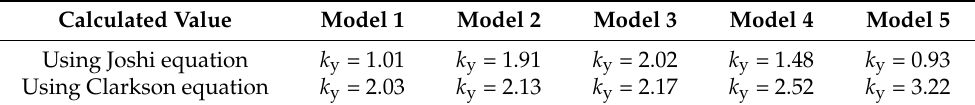
Table 3. Extracted permeability of the simulation example using single-phase (water) FMB.